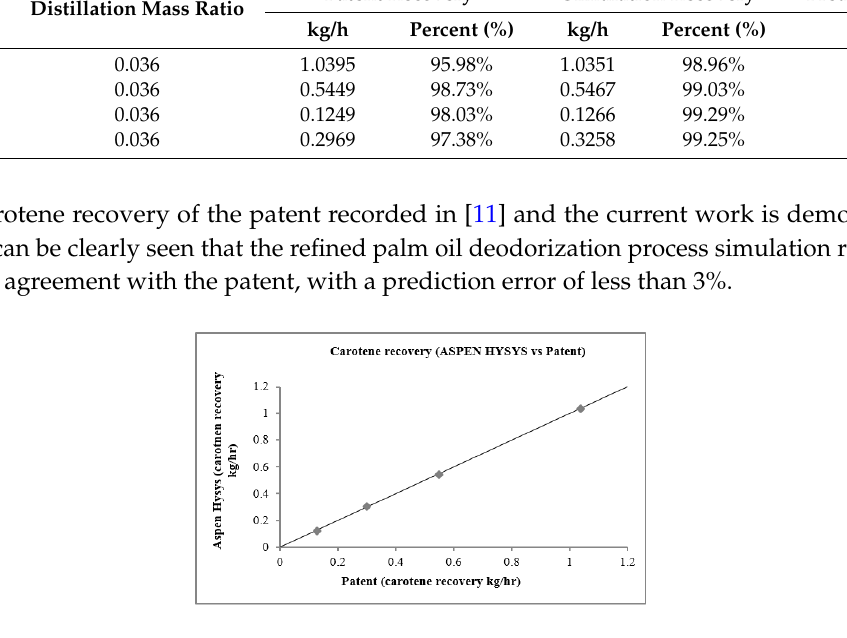
Figure 4. Carotene recovery of refining of edible oil in study [11] and this work.